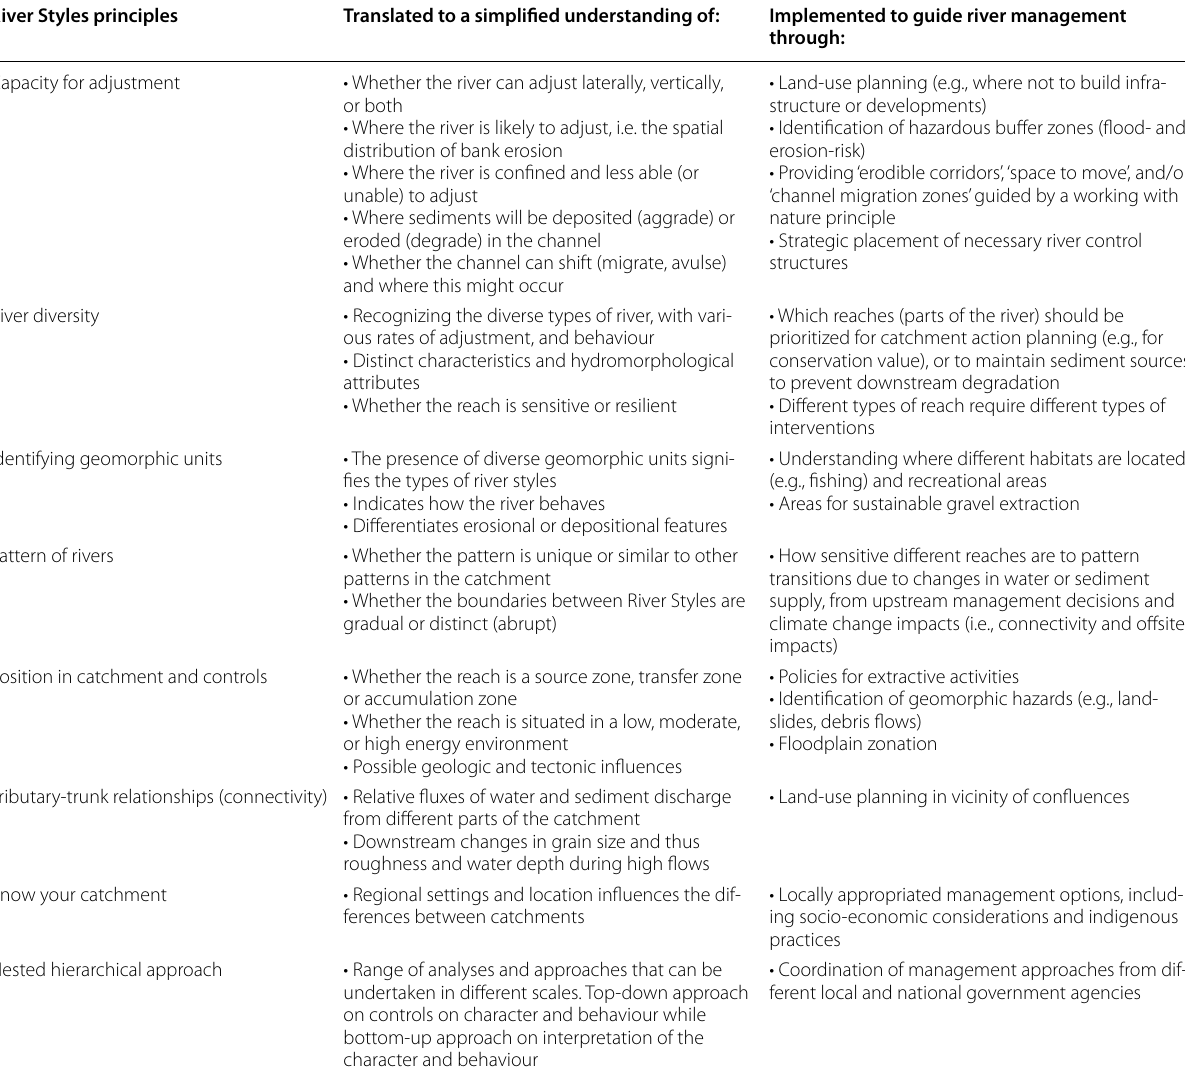
Table 2 River Styles principles that support the understanding of fluvial geomorphology and guide sustainable river management in the Bislak Catchment and more widely in the